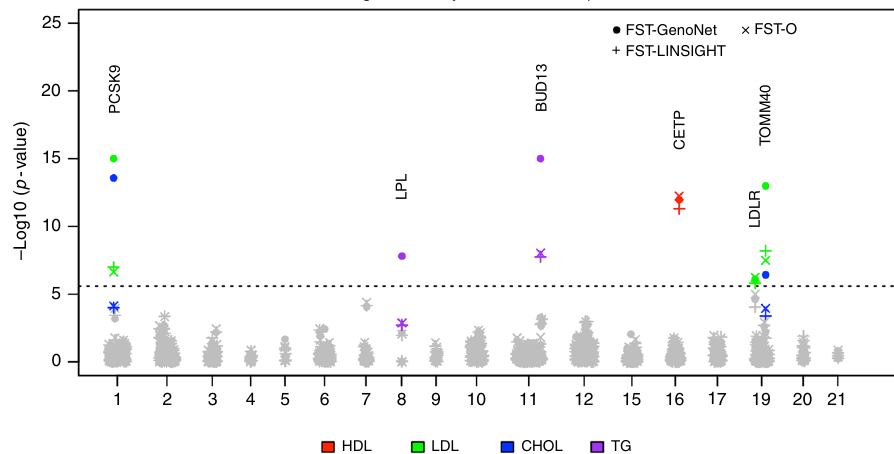
Fig. 7 Application of GenoNet scores to the meta-analysis of rare variants in Metabochip data. The fi gure shows the p -values of 266 genes in the 99 gold fi ne-mapped regions in the Metabochip study. FST-GenoNet: the functional score test proposed by He et al. 35 , integrating the GenoNet scores over 127 Roadmap tissues. FST-O: the original test combining burden and dispersion tests without integrating any functional scores (equivalent to SKAT-O); FST- LINSIGHT: the FST test integrating the organism-level prediction method LINSIGHT. The dashed line corresponds to the gene-based genome-wide signi fi cance level (2.5 × 10 − 6 ). When either FST-GenoNet, FST-O, or FST-LINSIGHT passes the signi fi cance level, all methods are highlighted for that gene- trait association. The X axis presents the chromosome on which the genes